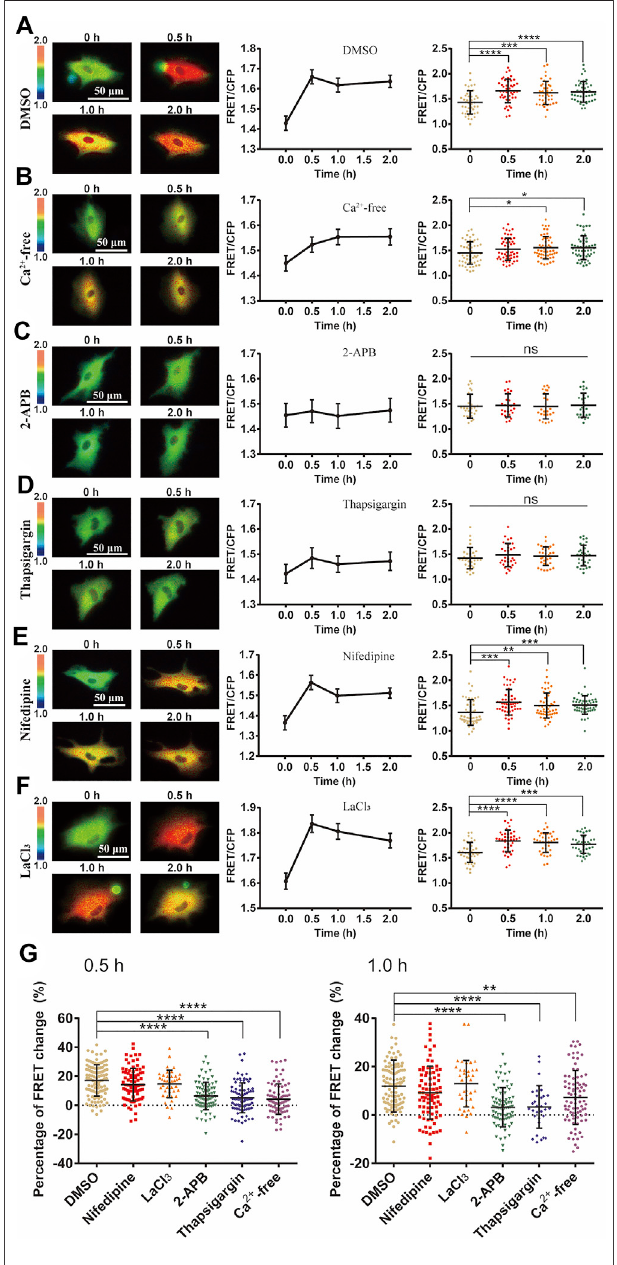
FIGURE 3 | Ca 2+ channel-dependent ERK activation by cyclic stretch. ASM cells were pretreated with inhibitors of variable Ca 2+ channels followed by cyclic stretch and imaging. FRET ratiometric images along with FRET change quanti fi cationsareshownforeachconditionbeforeandaftercyclicstretch. (A – F) FRET changes ofERK biosensor incells under control(0.1% (v/v) DMSO) condition (N= 42) (A) ; inCa 2+ -free culturemedium( n = 53) (B) ; pre-treated with